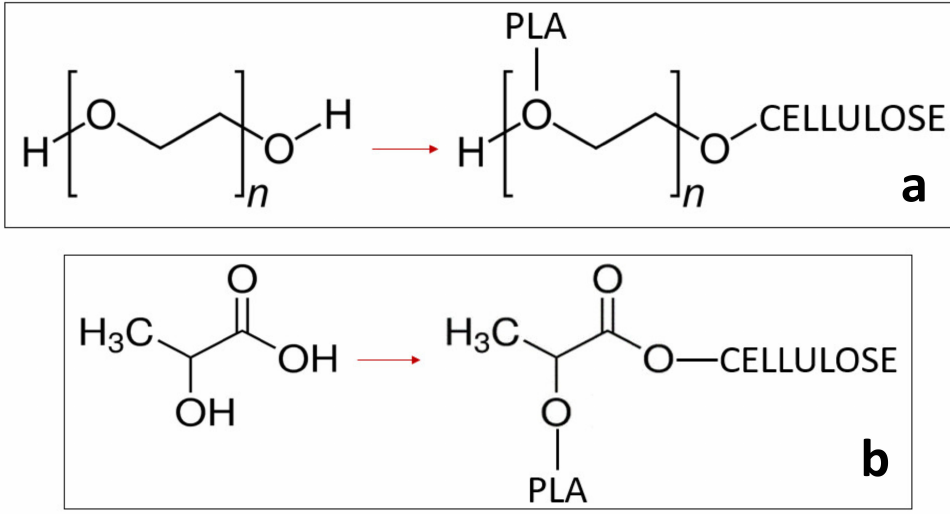
Figure 10. ( a ) Proposed PEG 400 composite chemical structure; ( b ) proposed OLA 2 composite chemical